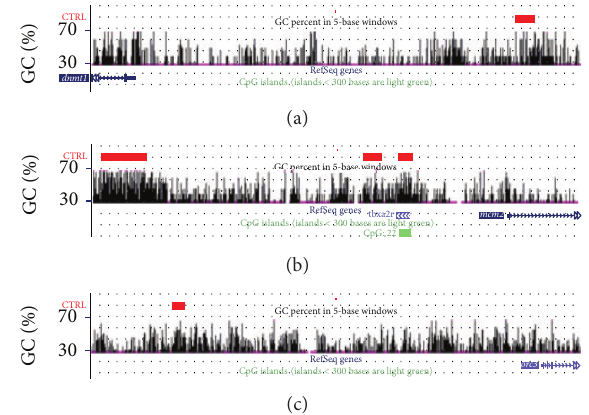
Figure 7: DNA methylation patterns within MRs of genomic areas upstream of the TSS for the dnmt1 , mcm2 , and orc3 genes (Panels (a), (b), and (c), resp.). The zebrafish genes (and associated upstream genomic regions) were analyzed in regard to (1) methylated regions, (2) percent GC content, and (3) CpG islands. CpG islands are defined as containing at least 50% of CG dinucleotides within a region of at least 200 bp. As in Figure 4, red bars represent methylated regions (MRs) as defined by the MACS algorithm for the zebrafish genes and black vertical bars represent GC content in the selected genomic region. For mcm2 , the three red bars represent MRs 1, 2, and 3 as depicted in Figure 4. Green bars (when present) indicate CpG islands (CpG island is a region with at least 200 bp and a GC percentage that is greater than 50% and with an observed-to- expected CpG ratio that is greater than 60%). Notice that the red bars overlay areas of elevated GC content that are not classified as canonical CpG islands except for the far right red bar for mcm2 , as indicated by the lower green bar to the right of center in Panel